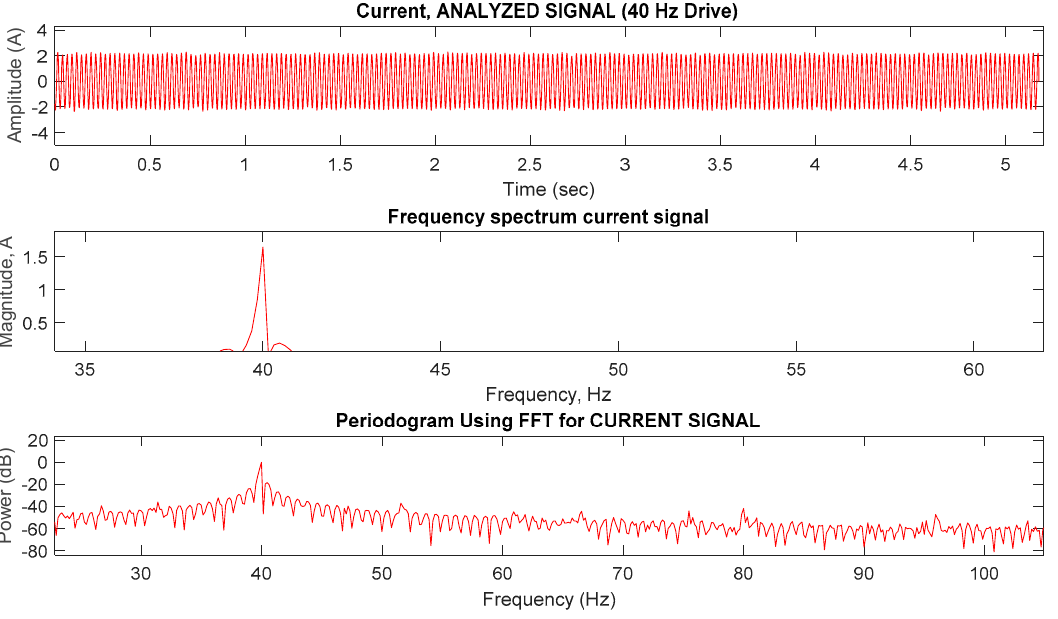
Figure 10. FFT analysis of current signal measurement of motor line current of phase A, frequency spectrum, and periodogram at 40 Hz speed operation.